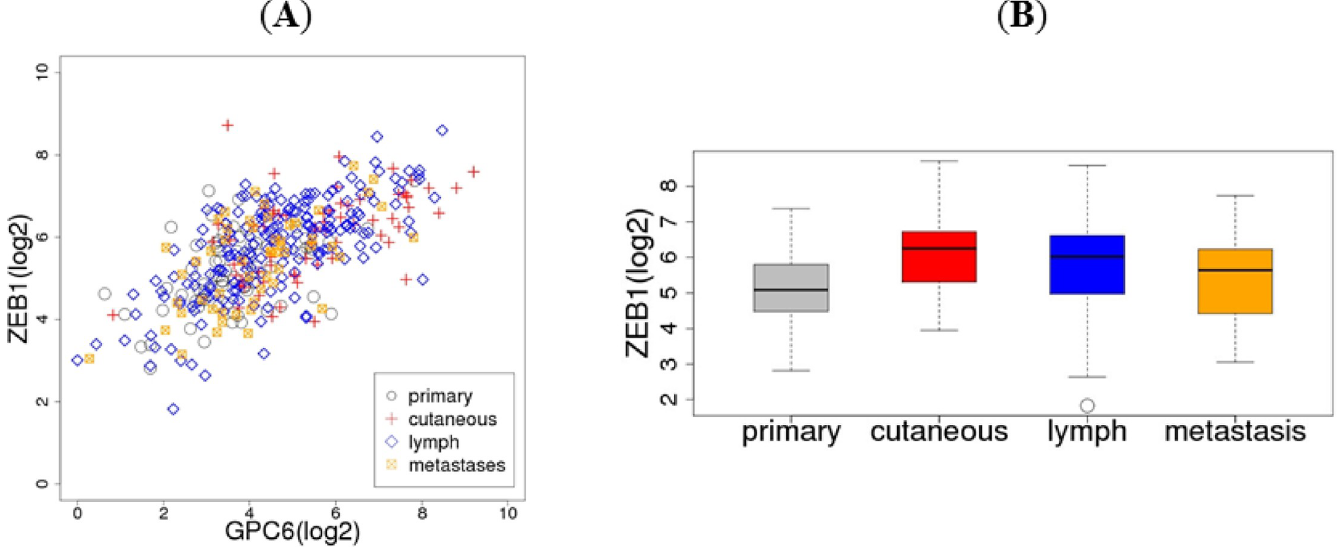
Fig 4. Correlation between GPC6 and ZEB1 expression. (A) GPC6 expression is correlated with ZEB1 in TCGA cutaneous skin melanoma samples. (B) Boxplots of RNA-seq expression levels of ZEB1 in TCGA cutaneous melanoma samples from primary site (skin), and metastases to cutaneous/subcutaneous tissue, lymph node, and distant sites.